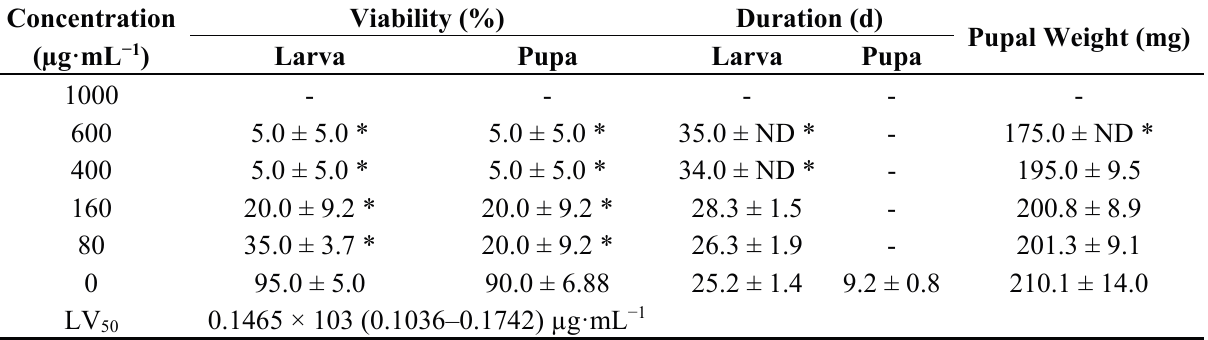
Table 4. Insecticide and insectistatic activities of Caryophyllene oxide against S. frugiperda . Concentration (µg·mL − 1